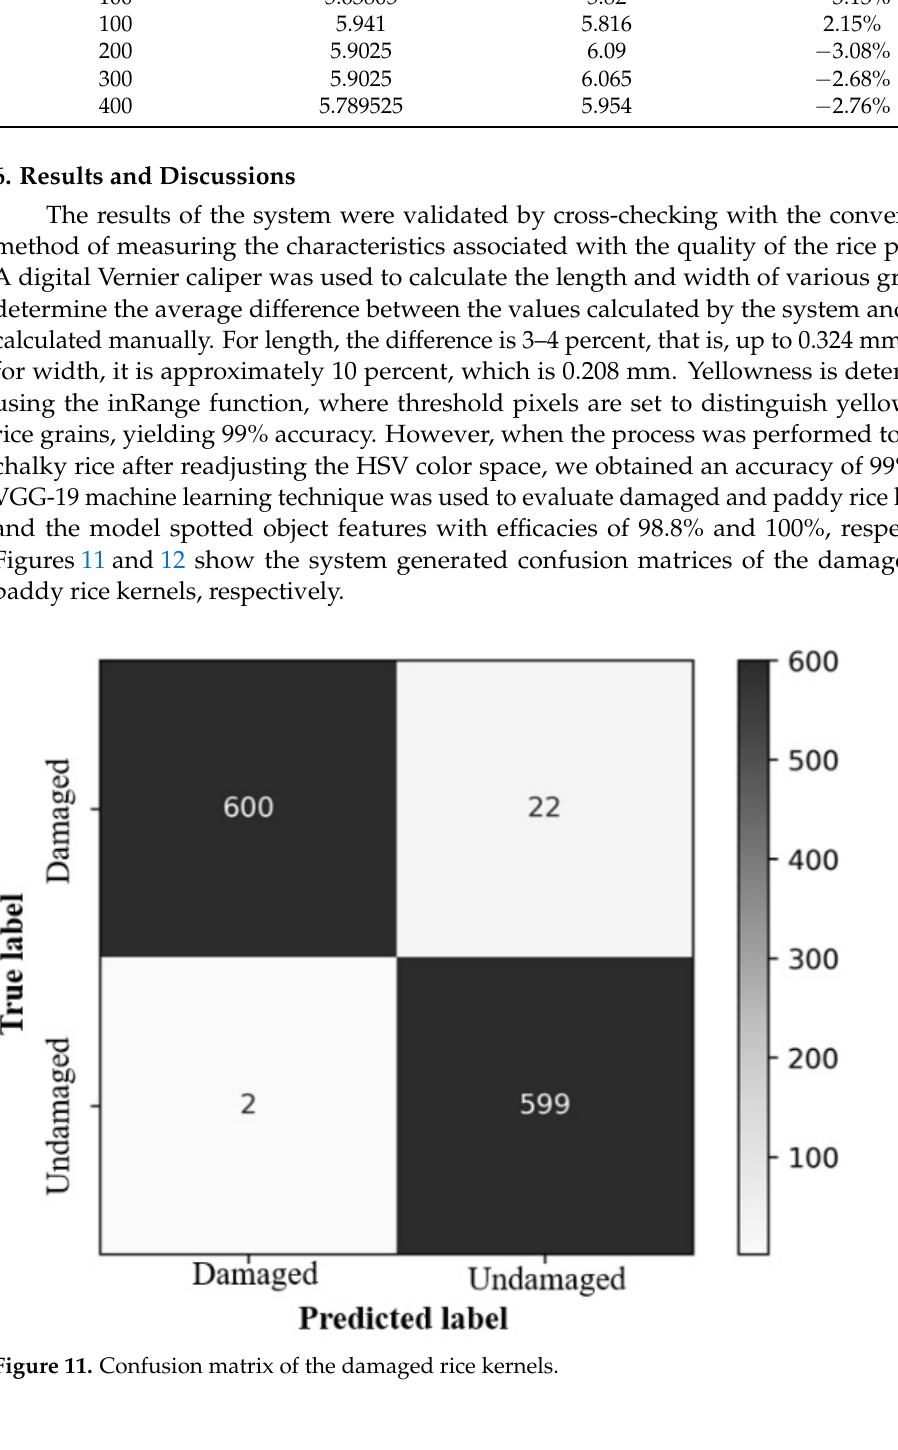
Figure 12. Confusion matrix of the paddy rice kernels . To predict the weight of the kernel, a random forest regression model was employed; the dataset was split into two features, no trees (estimators) were 100, and the decision was made according to the performance of the tree based on the RMSE and MAPE of the testing dataset, which was 1.21 × 10 − 8 and 6.7 × 10 − 5 , respectively. Based on the values of RMSE and MAPE, the system showed 99% accuracy. Figure 13 shows a graphical repre- sentation of the predicted and true weight values of the rice kernel.